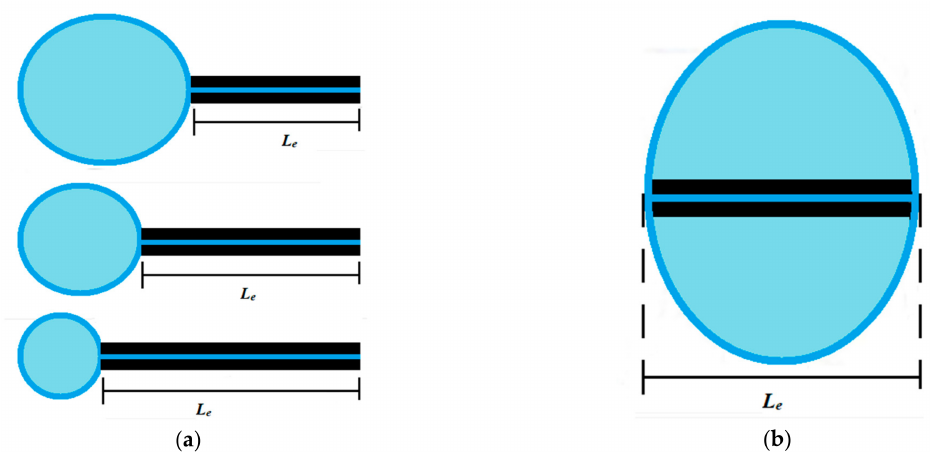
Figure 10. ( a ) Depiction of the electrode coverage of the unintegrated electrohydraulic coupling with the zip mechanism and parallel plate mechanism geometries ( b ) and the integrated electrohydraulic coupling, like the slide mechanism